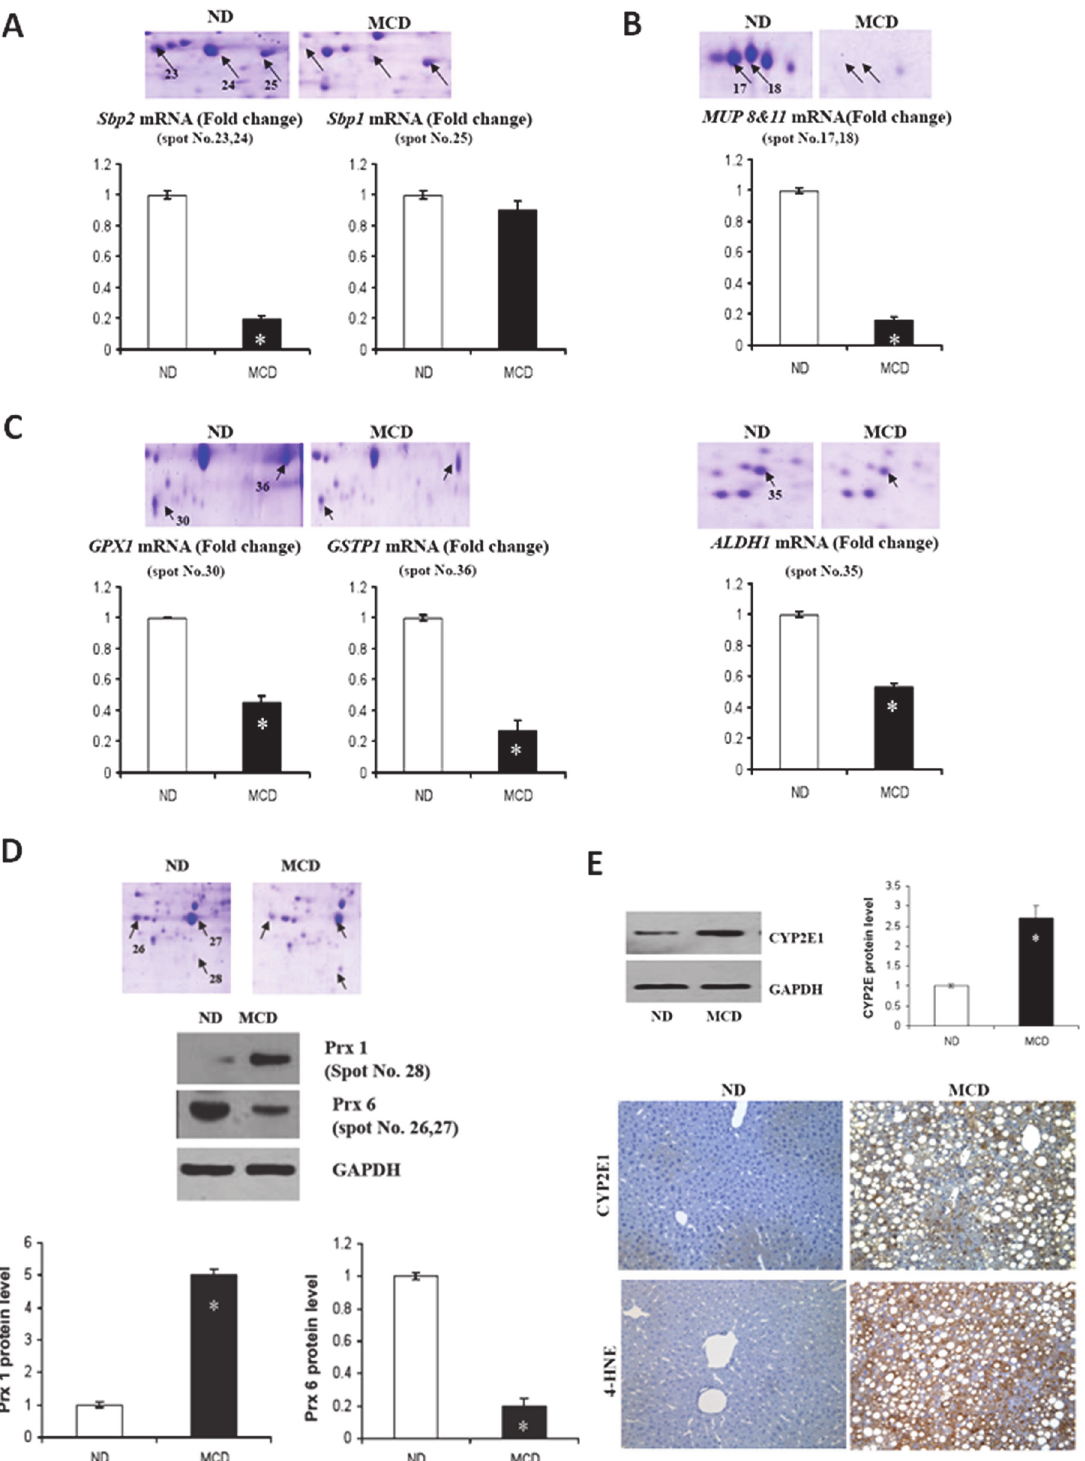
Fig 4. Validations of selected proteins including antioxidant protein. Liver tissue extracts were prepared from mice fed the MCD or the ND. Representative sections of 2-D gels are amplified to depict some of the identified proteins. The relative expression levels of mRNA were determined by qRT-PCR analysis. Commonly, liver extracts from a pool of 3 mice in each group were used. Genes were normalized to GAPDH RNA as an internal standard, and data are shown as fold change. * P < 0.05. (A) Upper panel shows hepatic expression levels of Sbp 2 (spot 23 & 24) in the ND and MCD